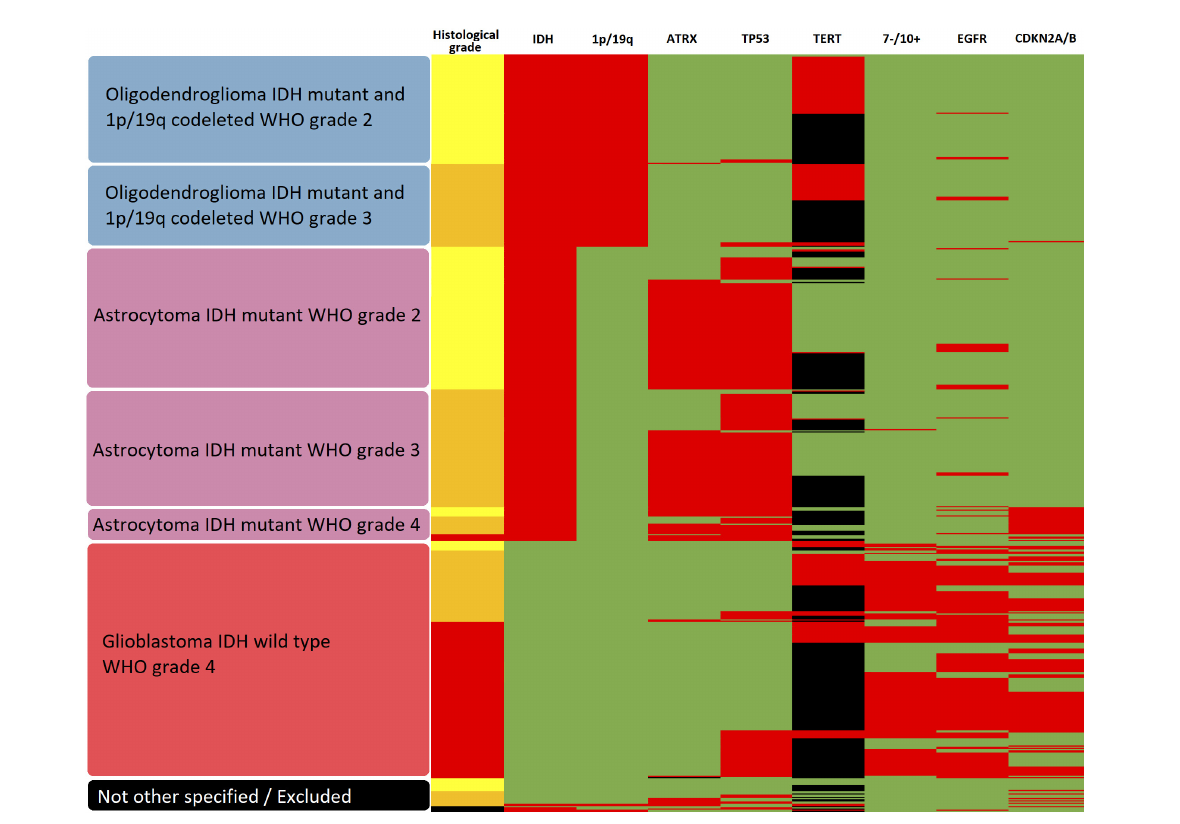
FIGURE2 Heatmap of subgroups according to molecular glioma markers. The resulting molecular glioma subgroup as well as histological tumor grade and molecular marker status for IDH mutation, 1p/19q codeletion, ATRX loss, TP53 mutation, TERT promoter methylation, 7-/10 + aneuploidy, EGFR amplification and homozygous CDKN2A/B loss is shown for each analyzed tumor. In regard to histological grade, yellow represents WHO grade 2, orange WHO grade 3 and red WHO grade 4. For all molecular markers, green represents the unaltered status whereas red shows the presence of IDH mutation, 1p/19q codeletion, ATRX loss, TP53 mutation, TERT promoter methylation, 7-/10+ aneuploidy, EGFR amplification and homozygous CDKN2A/B loss, respectively. Missing data is represented in